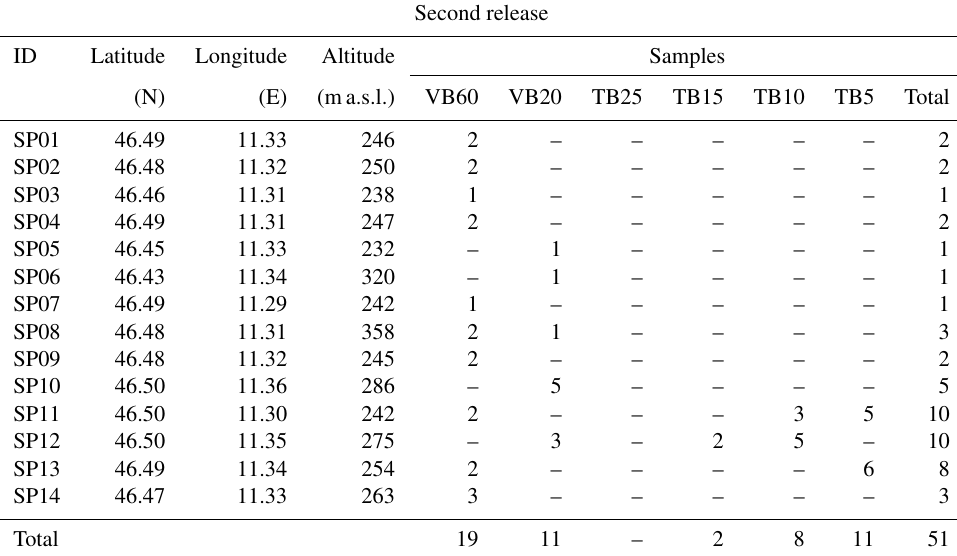
Table 5. Geographical coordinates of the sampling points (SP) along with number of samples of ambient air collected during the second release of BTEX (VB: vacuum-filled glass bottle; TB: PVF bags). The numbers after VB and TB indicate the duration in minutes of the sampling.